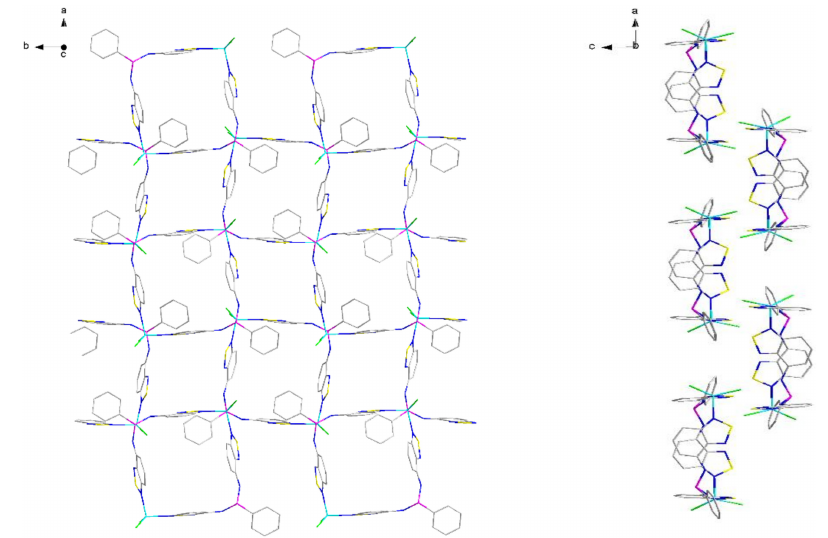
Figure 8. Crystal packing for 2b · 2.5C 7 H 8 . Hydrogen atoms and solvate molecules are not shown.